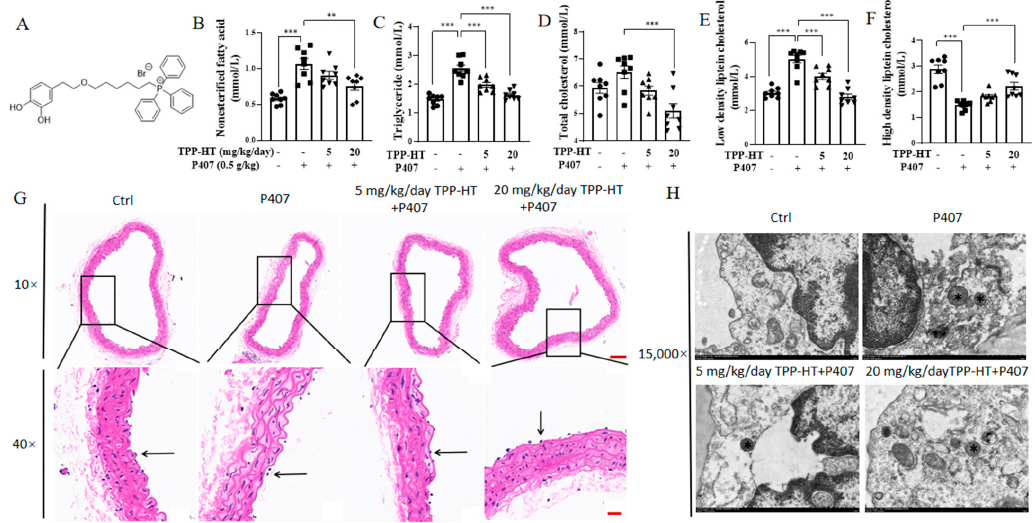
Figure 1. TPP-HT prevents P407-induced serum lipid profile abnormalities and endothelial and mi- tochondrial injury in the thoracic aorta. ( A ) Chemical structure of TPP-HT. ( B − F ) Nonesterified fatty acids, triglycerides, total cholesterol, low-density lipoprotein cholesterol and high-density lipopro- tein cholesterol. ( G ) H&E staining of microstructural changes in the thoracic aorta. The arrow indi- cates thoracic aortic endothelial cells, scale bar = 100 μ m ( upper ) and 20 μ m ( lower ). ( H ) Ultrastruc- tural changes in the thoracic aorta; asterisk indicates swelling mitochondria, scale bar = 1 μ m. Con- trol group ( n = 8), hyperlipidemia group ( n = 8), low-dose TPP-HT group ( n = 8), high-dose TPP-HT group ( n = 8). Values are the mean ± SEM. ** p < 0.01, *** p < 0.001. 3.2. TPP-HT Prevents PA-Induced Cellular Lipotoxicity, Increases Inflammation and Decreases eNOS Expression in HAECs To investigate how TPP-HT ameliorates endothelial damage, our study constructed a cellular model with HAECs and PA. PA challenge was employed to induce lipotoxicity- associated endothelial dysfunction [19]. HAECs were pretreated with TPP-HT (1, 5, 10, 25, 50 μ M) for 24 h, followed by PA challenge (500 μ M) for another 24 h. The results of CCK-8 detection showed that PA sharply decreased cell viability (67.16 ± 10.42% of the BSA control), and TPP-HT (5 and 10 μ M) showed protective effects on cell viability in comparison with the PA-alone-treated group (Figure 2A), which was in accordance with the microscopy results (Figure 2B). Inflammation is the main factor participating in endo- thelial dysfunction [22]. Inflammatory factors interleukin 6 (IL-6) and matrix metallopro- teinase 1 (MMP-1) were drastically increased by PA challenge (1132.0 ± 313.6 and 750.2 ± 150.2% of BSA control, respectively), which were dramatically ameliorated by TPP-HT (5 and 10 μ M) treatments (Figure 2C,D). Thus, to reach sufficient protective effects of TPP- HT, we then used 10 μ M TPP-HT treatment for 24 h in the following tests. Moreover, the anti-inflammatory effects of TPP-HT were much better than the anti-inflammatory effects of HT in the PA-induced HAEC model (Figure 2E). Normal expression of eNOS in endo- thelial cells is absolutely essential for the normal functioning of blood vessels [23]. Free fatty acids (FFAs) are associated with endothelial dysfunction, specifically due to abnor- malities in the endothelium-derived nitric oxide system [24]. To characterize PA-induced endothelial dysfunction, eNOS expression was detected. As expected, 500 μ M PA chal- lenge for 24 h resulted in a sharp decrease in eNOS expression, which was recovered by 10 μ M TPP-HT pretreatment (Figure 2F,G), indicating that TPP-HT effectively blocked the impact of PA on eNOS expression.